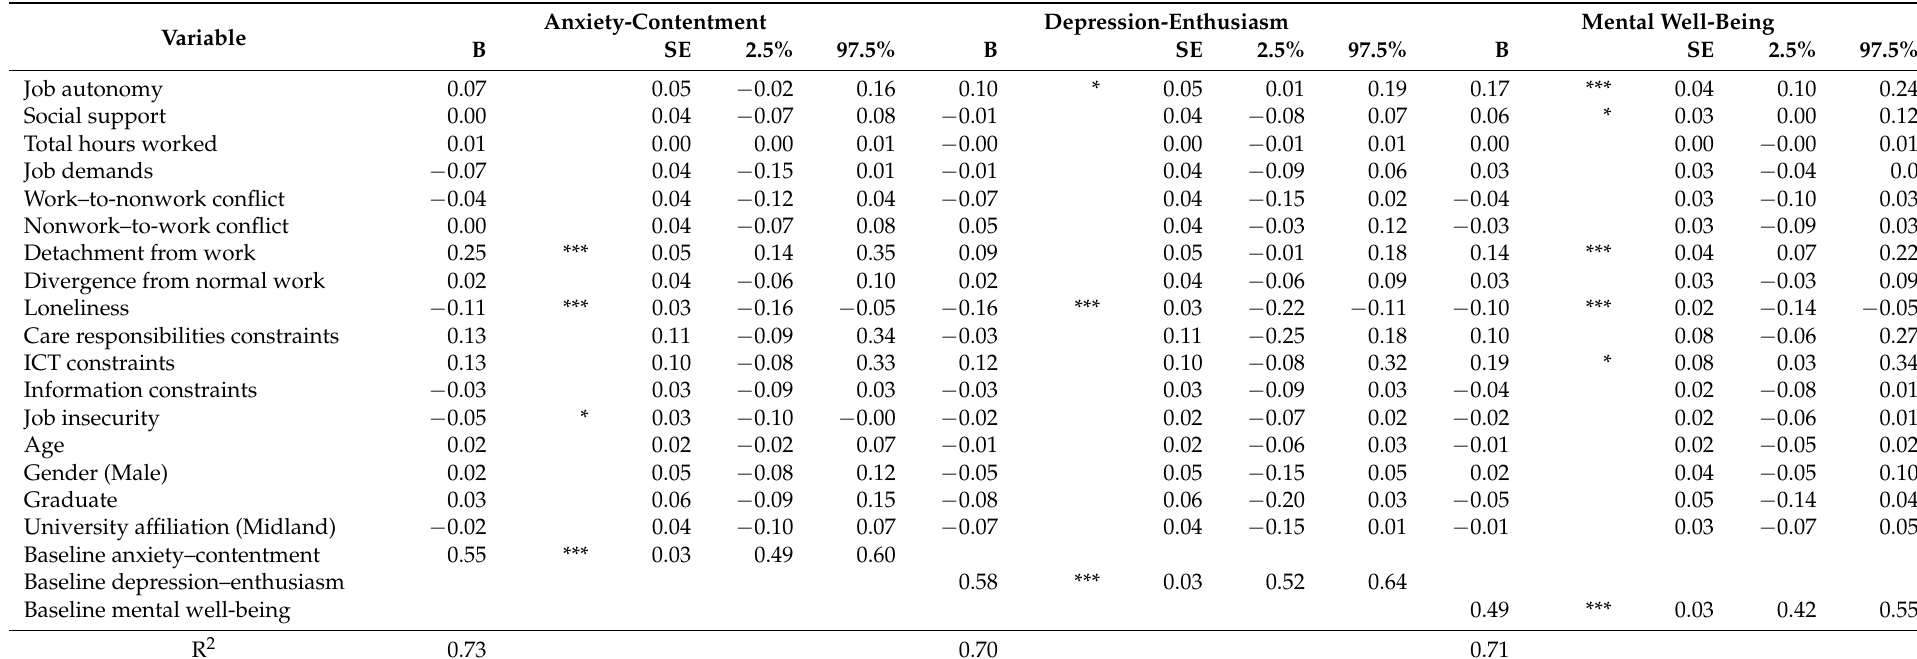
Table 7. Phase 2 between-person effects on